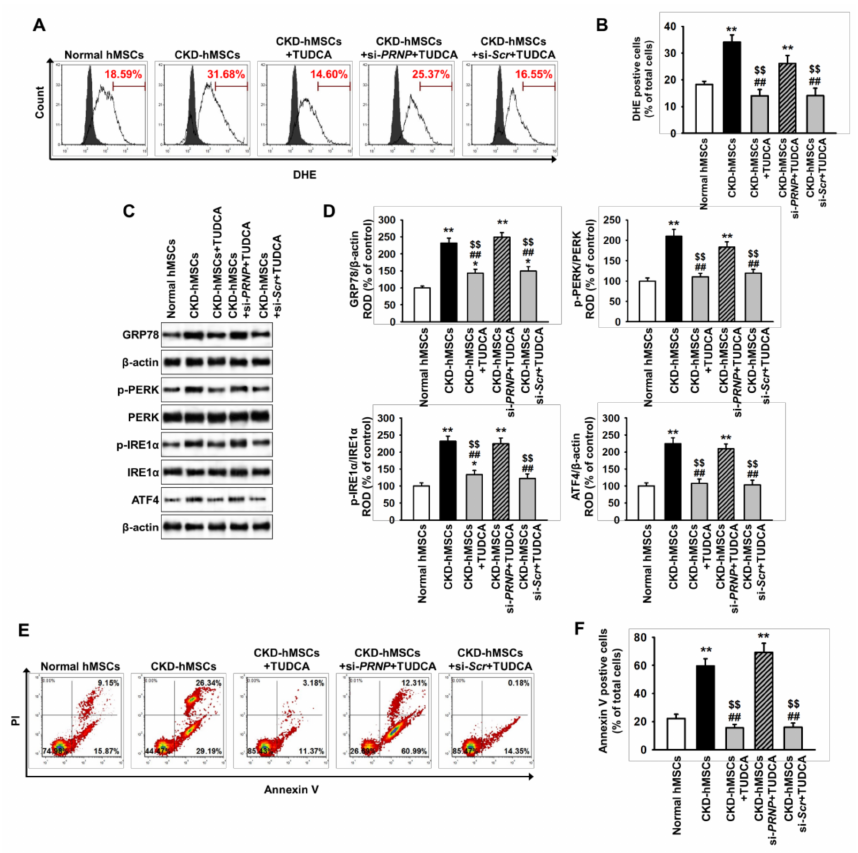
Figure 3. Co-culture with TUDCA-treated CKD-hMSCs prevents apoptosis of SH-SY5Y cells in the presence of uremic toxin through protection of ER stress. In the presence of P -cresol, SH-SY5Y cells were co-cultured with hMSCs and subsequently analyzed by flow cytometry analysis and western blot. ( A ) Flow cytometry analysis for DHE staining in SH-SY5Y cells after co-culture with hMSCs ( n = 5). The filled and clear histograms represent cells in the absence and presence of DHE, respectively. ( B ) Quantification of the percentage of DHE positive cells from ( A ). ( C ) Western blot analysis for GRP78, p-PERK, PERK, p-IRE1 α , IRE1 α , and ATF4 in SH-SY5Y cells after co-culture with hMSCs ( n = 3). ( D ) The protein levels of ( C ) were determined by densitometry relative to β -actin. ( E ) Flow cytometry analysis following PI/Annexin V staining of SH-SY5Y cells co-cultured with hMSCs ( n = 5). ( F ) Quantification of the percentage of Annexin V positive cells from ( E ). Statistical analysis: Values represent the mean ± SEM. ( B ) ** p < 0.01 vs. co-culture with normal hMSCs, ## p < 0.01 vs. co-culture with CKD-hMSCs, $$ p < 0.01 vs. co-culture with CKD-hMSCs + si- PRNP + TUDCA. ( D ) * p < 0.05, ** p < 0.01 vs. co-culture with normal hMSCs, ## p < 0.01 vs. co-culture with CKD-hMSCs, $$ p < 0.01 vs. co-culture with CKD-hMSCs + si- PRNP + TUDCA. ( F ) ** p < 0.01 vs. co-culture with normal hMSCs, ## p < 0.01 vs. co-culture with CKD-hMSCs, $$ p < 0.01 vs. co-culture with CKD-hMSCs + si- PRNP +